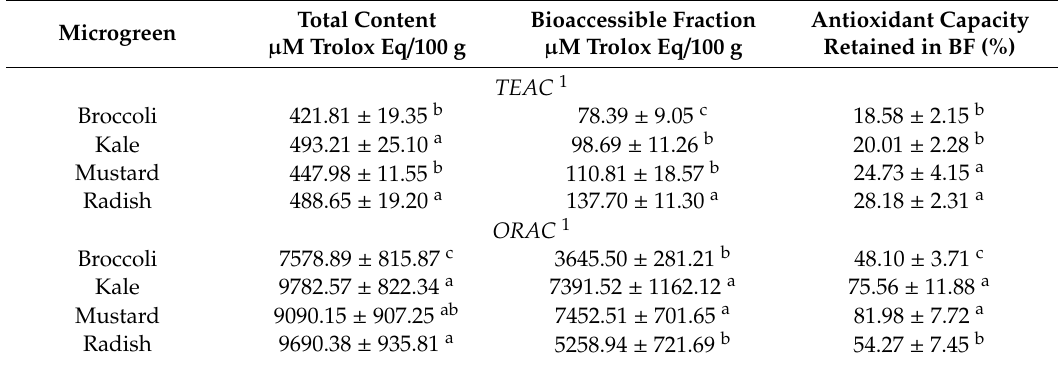
Table 3. Total antioxidant capacity before and after simulated gastrointestinal digestion in